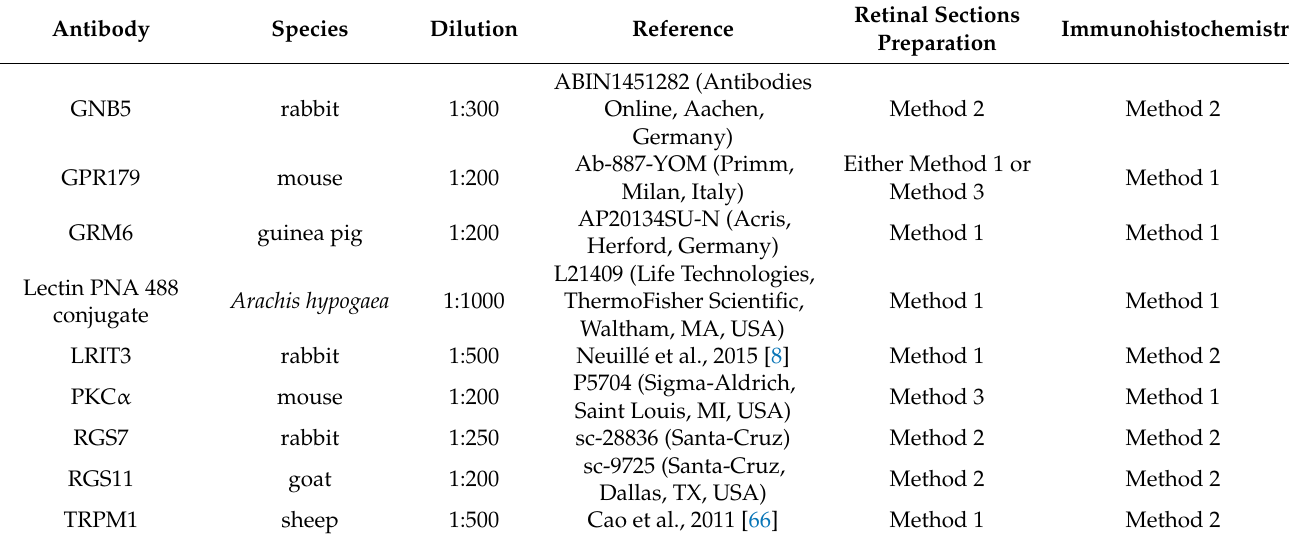
Table 1. Primary antibodies used in immunohistochemistry in this